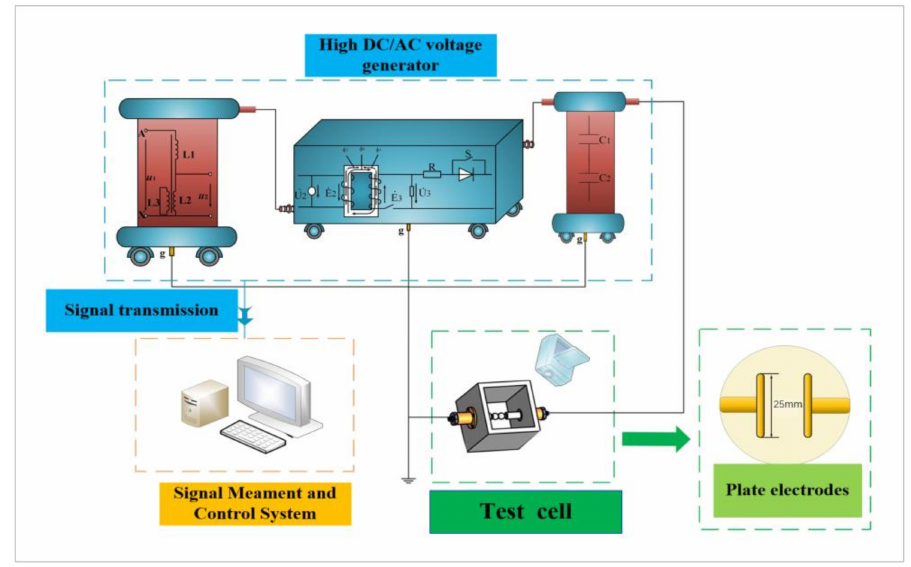
Figure 2. The experimental setup for particles accumulation and DC breakdown